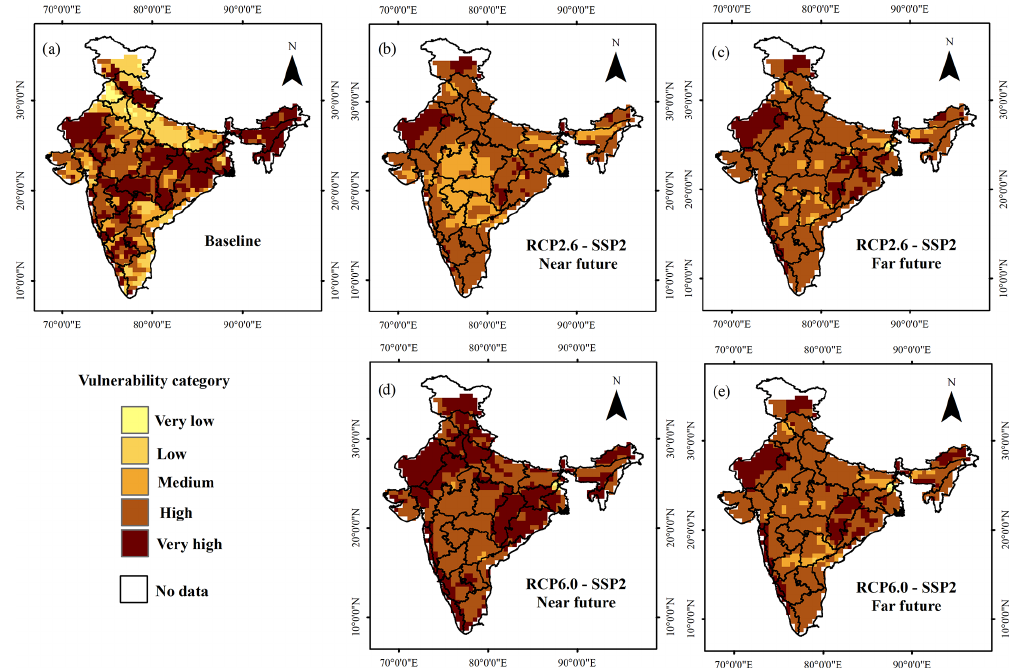
Figure 5. Multi-model ensemble drought vulnerability maps for the scenarios (a) baseline, (b) RCP2.6-SSP2-Near future, (c) RCP2.6-SSP2- Far future, (d) RCP6.0-SSP2-Near future and (e) RCP6.0-SSP2-Far future.